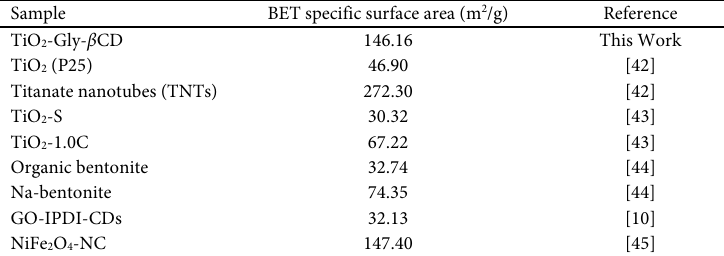
Table 1. EDX elemental microanalysis (wt. %) of TiO 2 , TiO 2 -Gly, and TiO 2 -Gly- β CD.